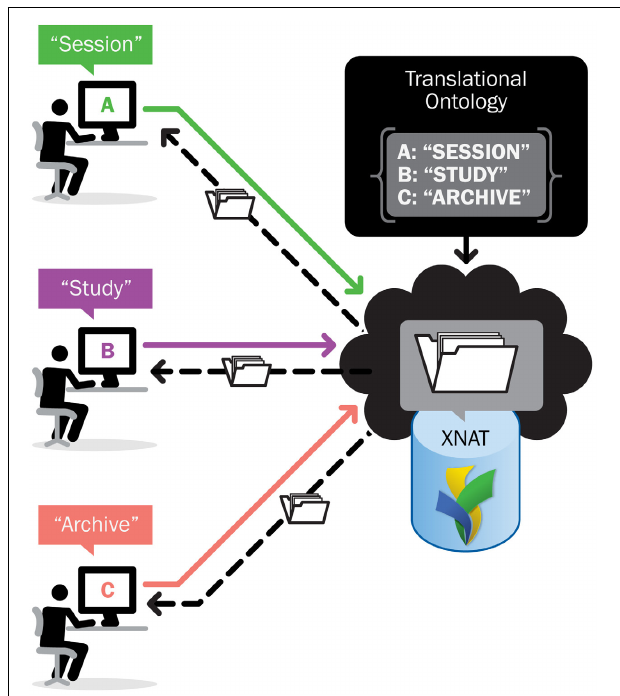
FIGURE 5 | Translation of different vocabularies to XNAT